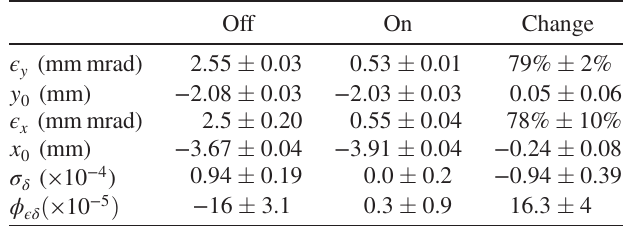
TABLE VI. Ejection plateau summary table. “ Off ” and “ on ” refer to the status of the electron cooler. Note: Changes in emittance are expressed as percentages of initial